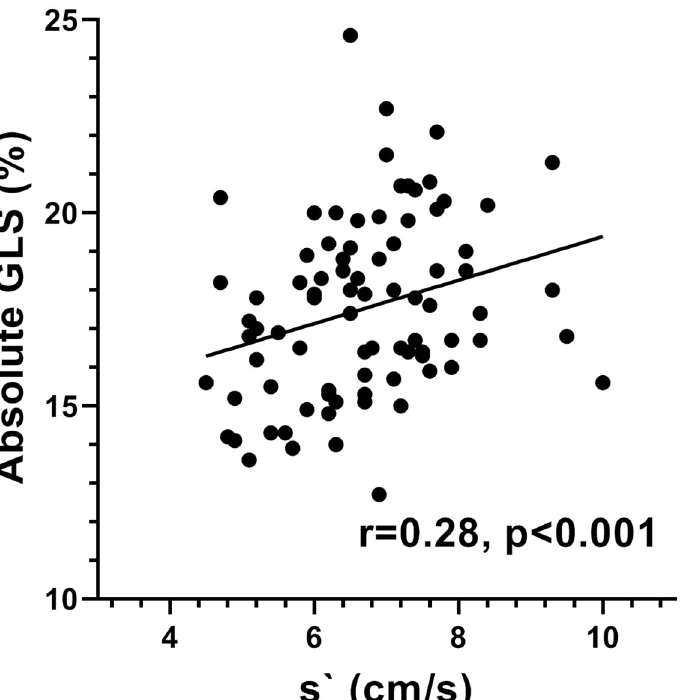
Fig 1. Scatter plot showing the relationship of the absolute value of GLS with